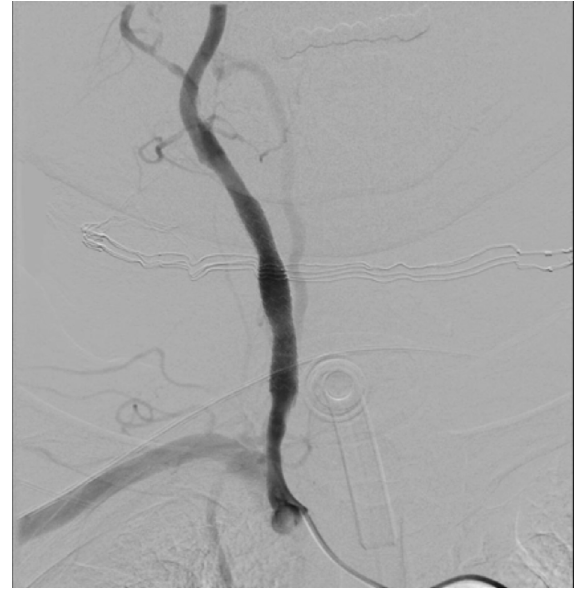
Left carotid artery stent in a patient who suffer a carotid blowout syndrome.